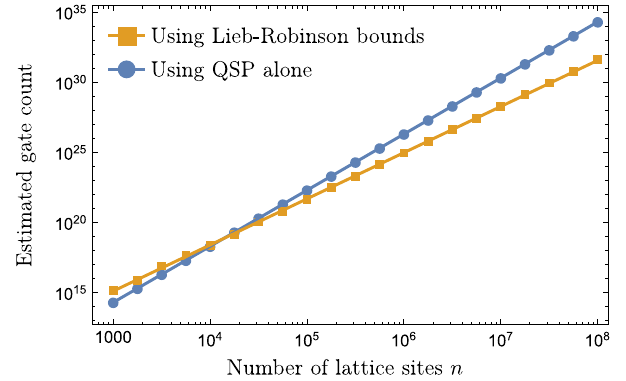
FIG. 5. The gate count for simulating the dynamics of a one- dimensional Heisenberg chain [Eq. (25)] of length n , with α ¼ 4 , T ¼ n , and ε ¼ 10 − 3 . We compare the gate count of the HHKL algorithm (orange square) to the QSP algorithm (blue circle). Note that the HHKL algorithm based on Lieb-Robinson bounds also uses the QSP algorithm as a subroutine. We obtain the scatter points using the approach described in Appendix E and fit them to a power-law model (solid lines). The asymptotic scalings of the gate count obtained from the power-law fits ( n 3 . 29 for HHKL, n 4 . 00 for QSP) agree well with our theoretical predictions (see Table I).